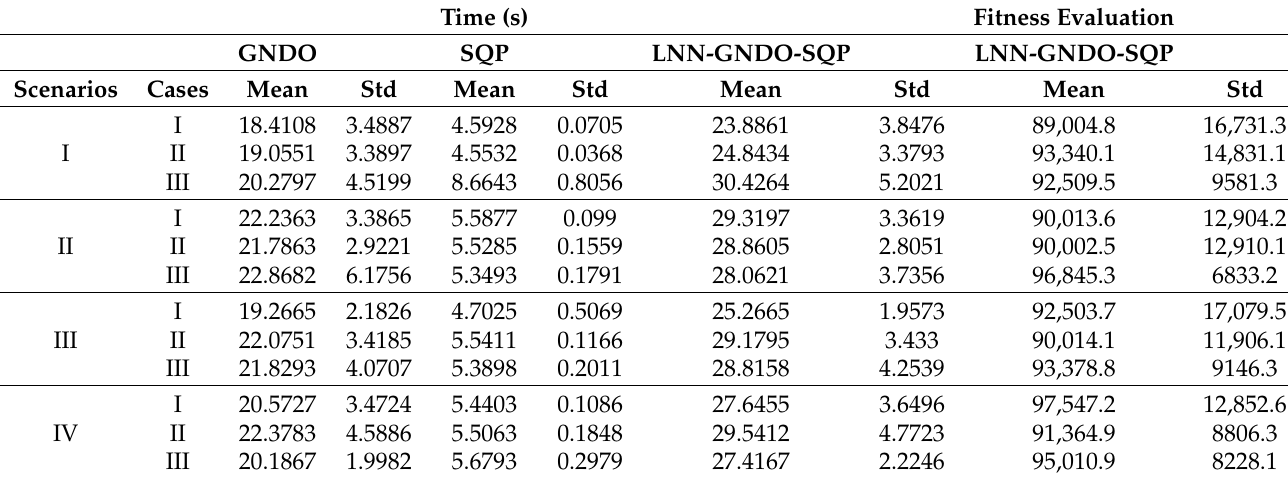
Table 2. Computational complexity analysis of the proposed algorithm for different cases of the drainage